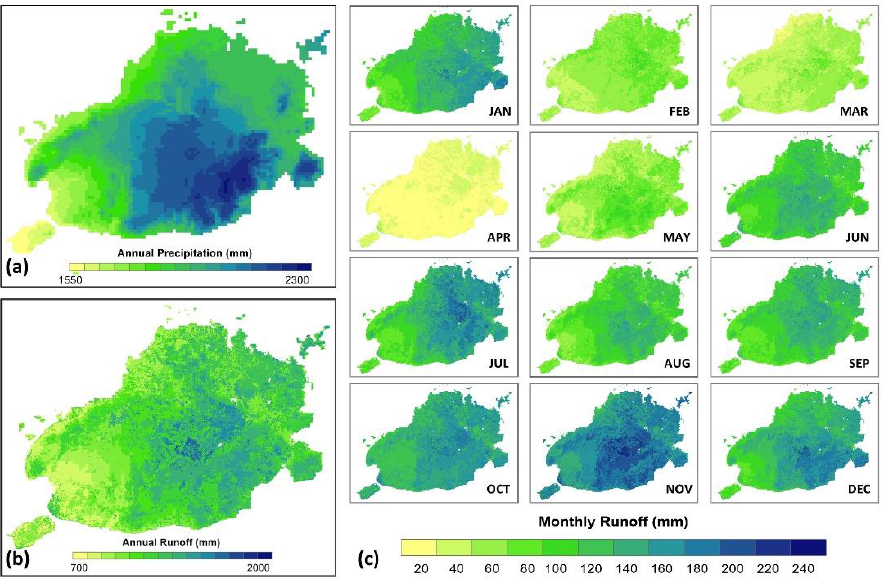
Figure 9. Spatial variation of ( a ) mean annual precipitation, ( b ) mean annual runoff depth, and ( c ) mean monthly runoff estimated using CN method.